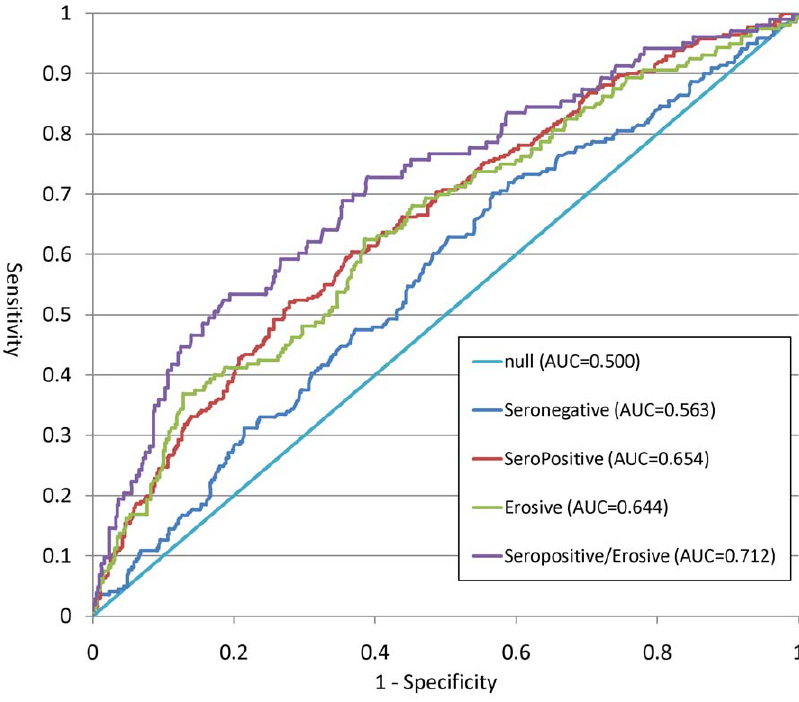
Figure 1. Receiver Operating Characteristic (ROC) curve for 4 phenotypes of RA.